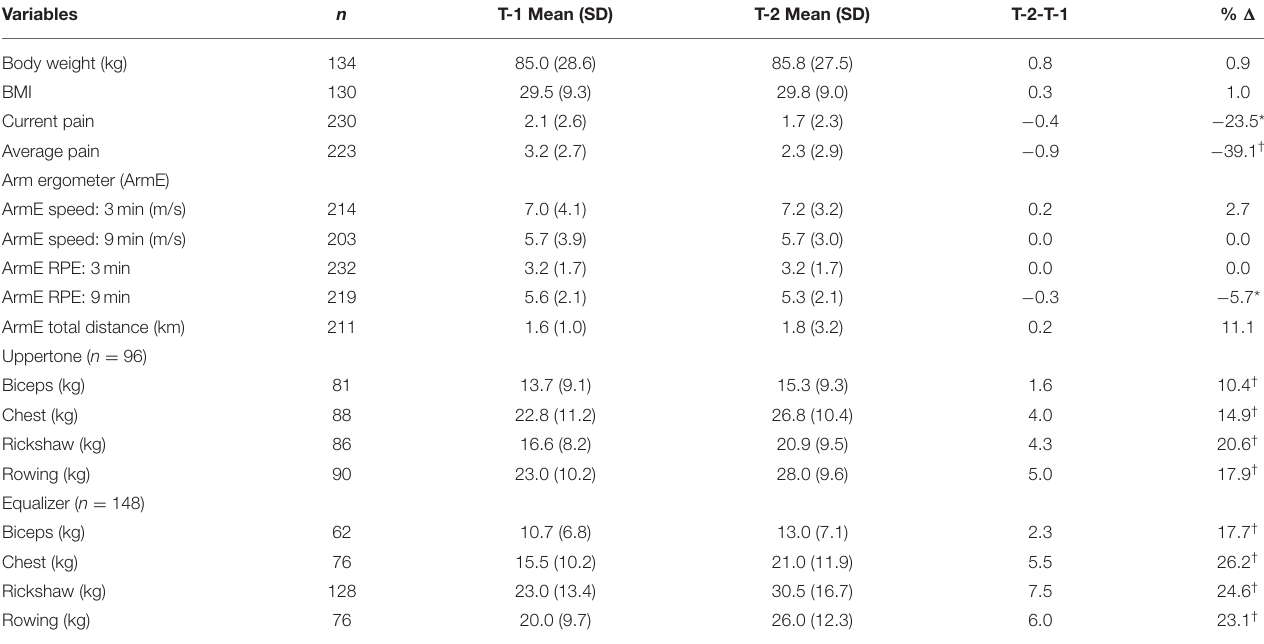
TABLE 3 | Influence of exercise on total intervention group ( N =